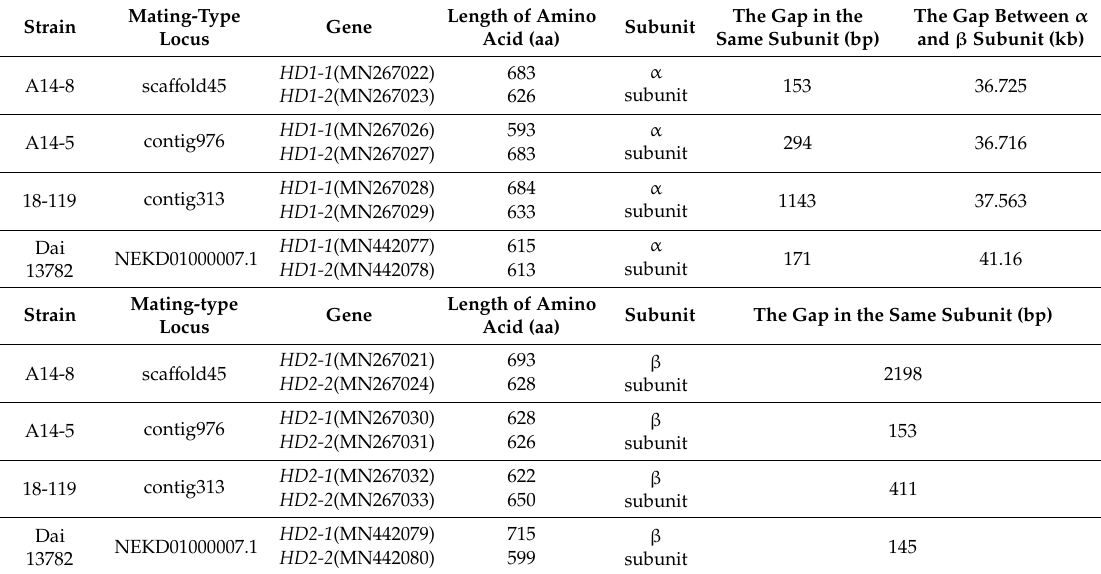
Figure 5. MAT-A mapping on the genetic linkage map. The bar in the middle represents the linkage group, the number on the left represents the genetic distance, the different SSR markers used for the construction of linkage map in this research are listed on the right according to the linkage relation. MAT-A represents the mating-type loci. Table 4. α and β subunit structure of the mating-type locus in the A. heimuer